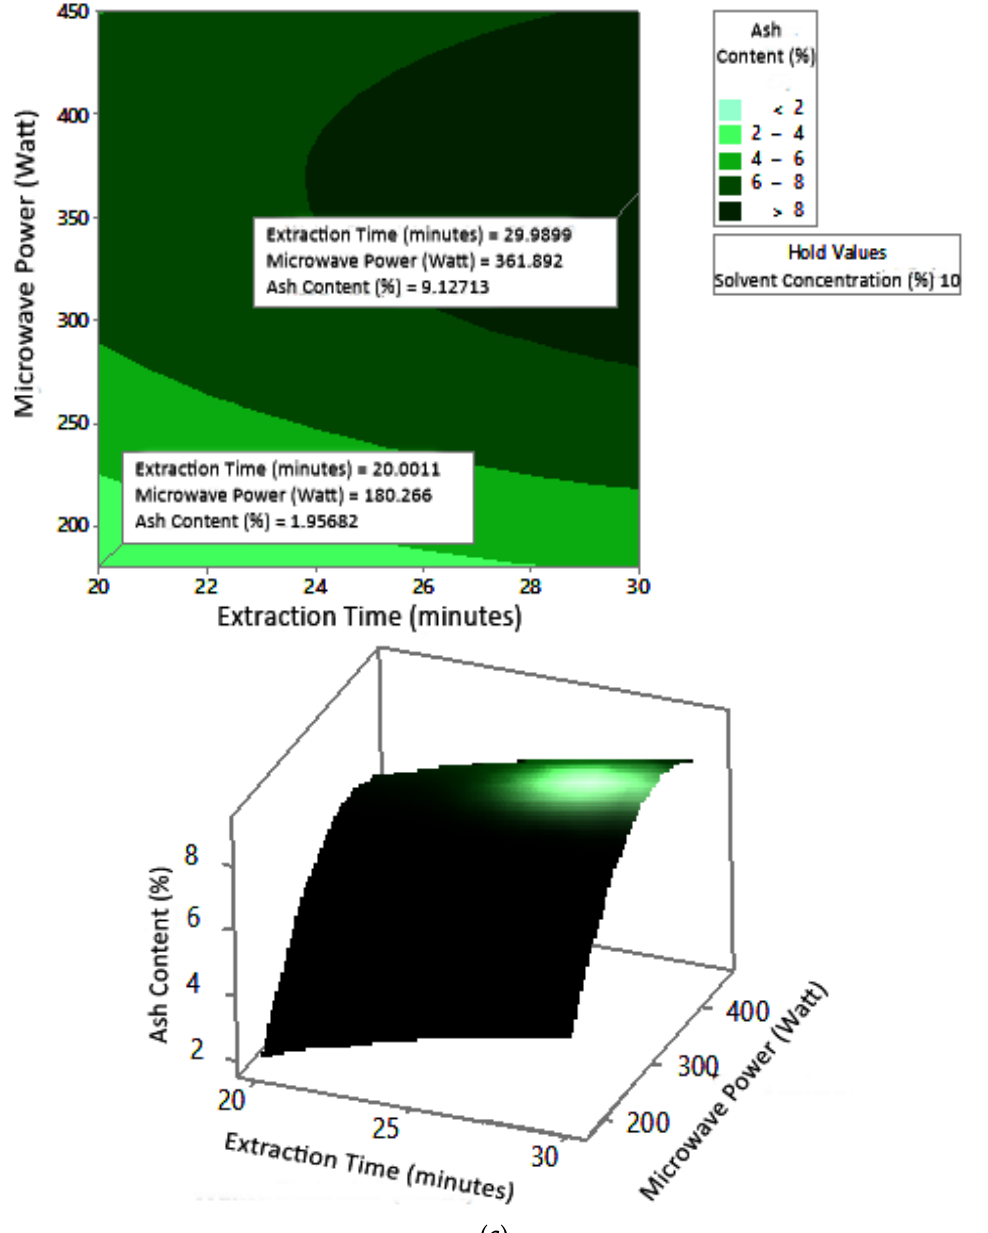
Figure 11. Effect of extraction time and microwave power on ash content at solvent